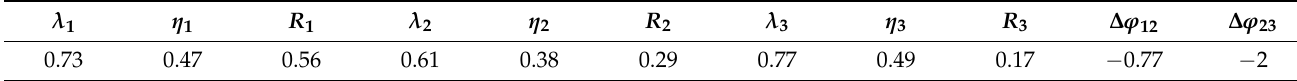
Table 2. Parameters after optimization.